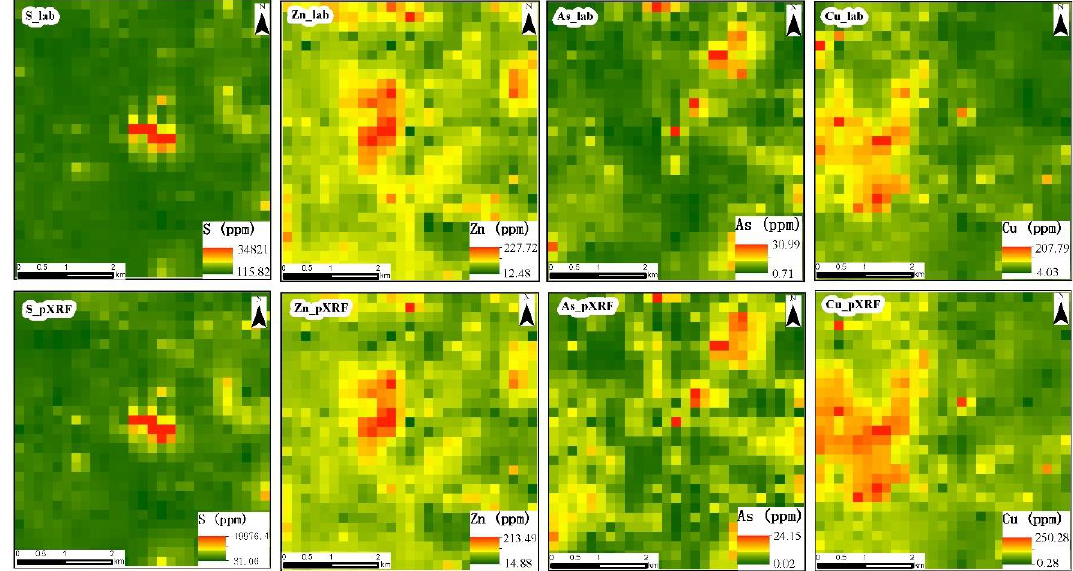
Figure 7. Spatial distribution of S, Zn, As, and Cu reported by laboratory (S_lab, Zn_lab, As_lab, Cu_lab) and pXRF (S_pXRF, Zn_pXRF, As_pXRF, Cu_pXRF).